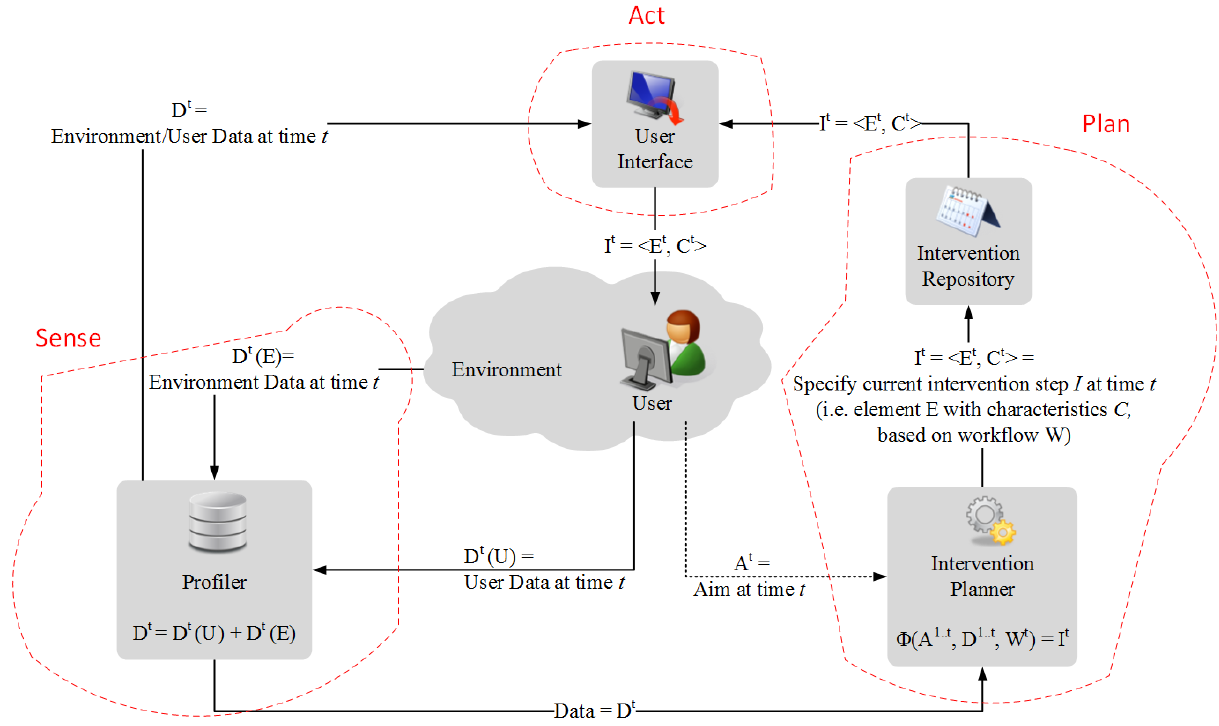
Figure 4. BIT-Tech framework: required environment and user data is collected by the Profiler component; collected data is passed to the Intervention Planner, which is responsible for planning intervention at time t; the Intervention Repository component stores all the interventions and passes specific details of the selected intervention to the User interface component, which then delivers the